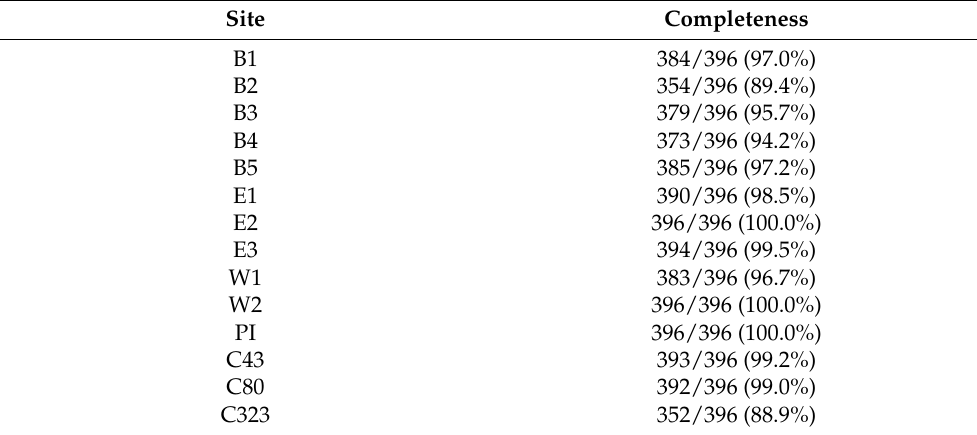
Table 2. PM 2.5 24 h samples calculated for